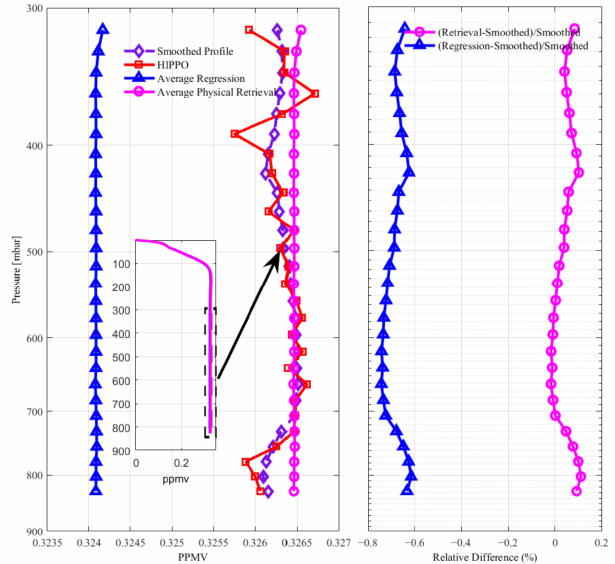
Figure 10. Average retrieval results for the 13 sample points matching the HIPPO data (left) and the RD between the retrieval results and the HIPPO data